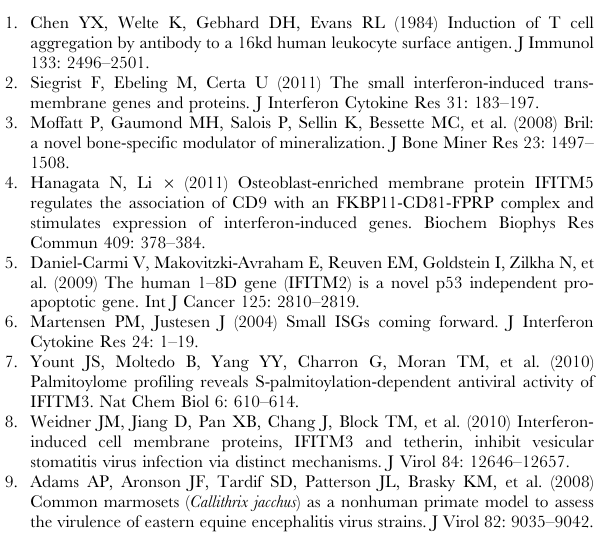
Figure S7 Positive selection analyses of IFITM genes with branch-site REL model in DATAMONKEY. Red lines indicate branches under positive selection. ( A ) Positive selection in primate and rodent IR-IFITM dataset. ( B ) Positive selection in vertebrate IFITM10 dataset. Table S1 Functional IFITM genes information used in this study. Table S2 Gene conversion analyses of IR-IFITM genes. Table S3 Twelve pairwise comparisons showing signif- icantly higher dN than dS for IR-IFITM genes. Table S4 Positively selected sites in IR-IFITM genes detected using MEME method implemented in DATA-